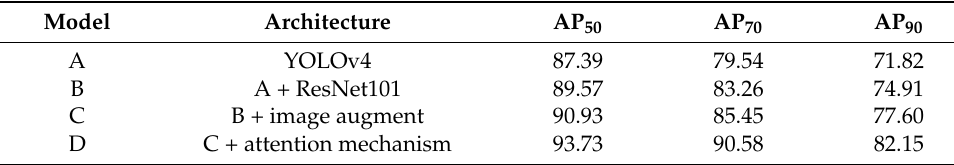
Table 10. The results of the ablation analysis.